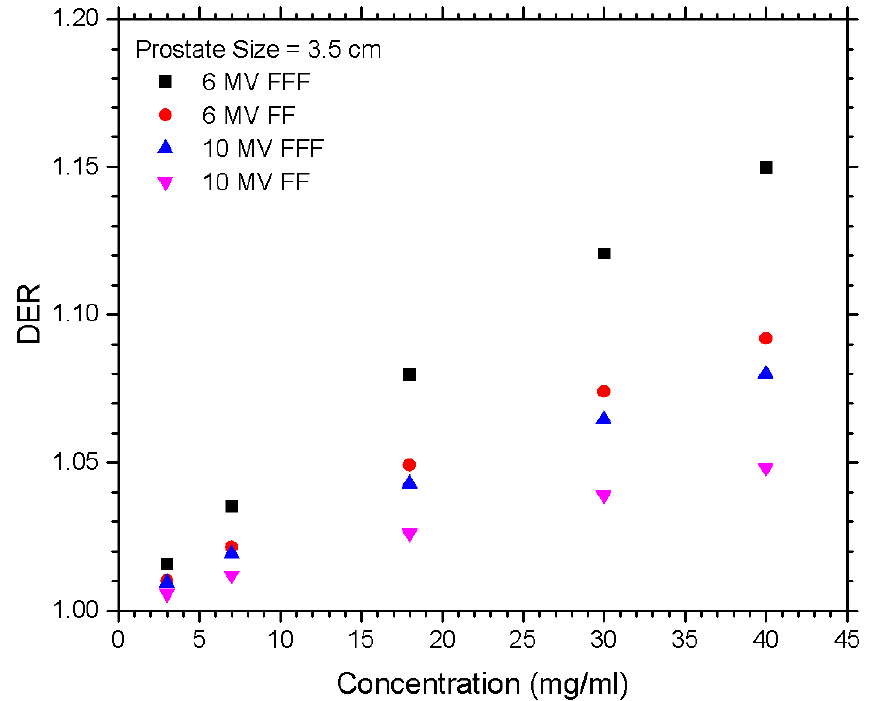
Figure 4. Relationships of the DER and gold nanoparticle concentration for the 6 MV FFF, 6 MV FF, 10 MV FFF, and 10 MV FF photon beams. The pelvic and prostate size were equal to 25 cm and 3.5 cm, respectively. The DER was calculated as the ratio of the target dose with nanoparticle addition to the target dose without nanoparticle addition under the same simulation